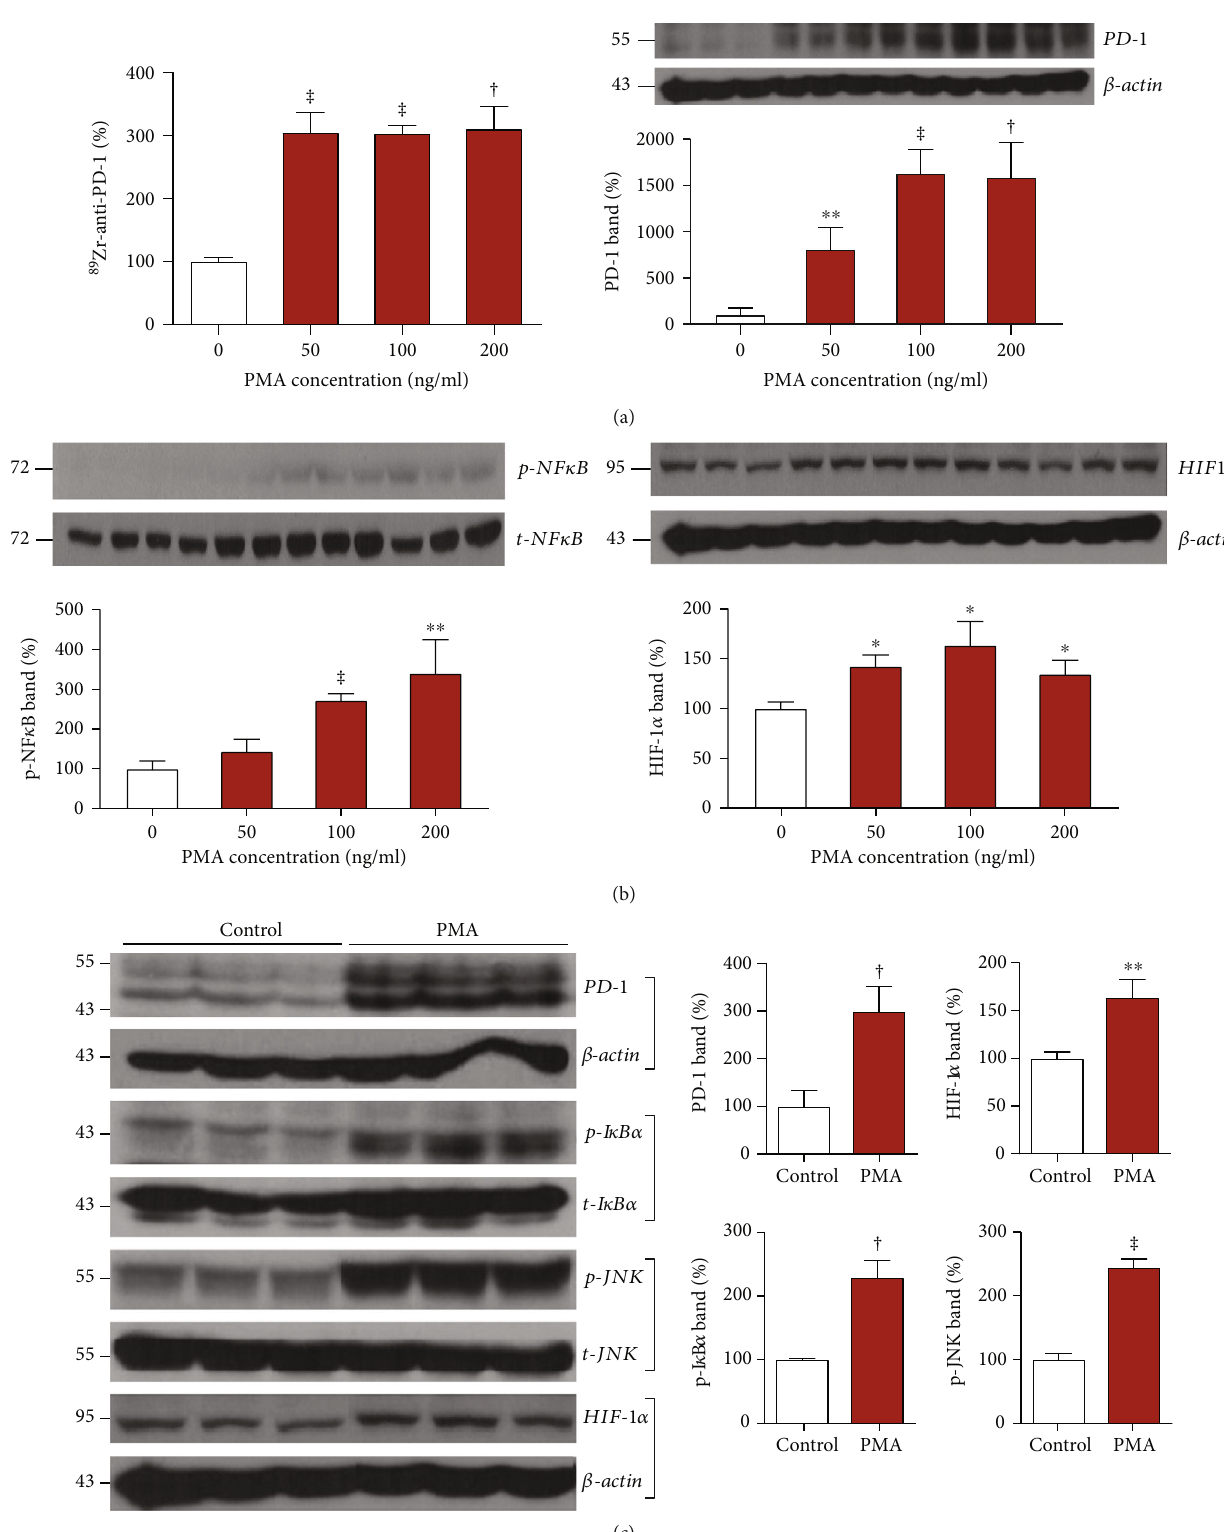
Figure 3: E ff ects of PMA stimulation on cultured EL4 cells. (a) E ff ects of 24 h treatment with graded doses of PMA on 89 Zr-PD-1 IgG binding (left) and PD-1 immunoblots with β -actin-corrected band intensities (right). (b) E ff ects of graded doses of PMA on Western blots of p-NF κ B (left) and HIF-1 α (right) with quanti fi ed protein band intensities that are corrected by controls. (c) Immunoblots of PD- 1, HIF-1 α , p-I κ B α , and p-JNK with quanti fi ed protein band intensities corrected by controls at baseline and following 24h treatment with PMA. All bars represent the mean ± SD of triplicate samples per group. ∗ P < 0 : 05 , ∗∗ P < 0 : 01 , † P < 0 : 005 , and ‡ P < 0 : 001